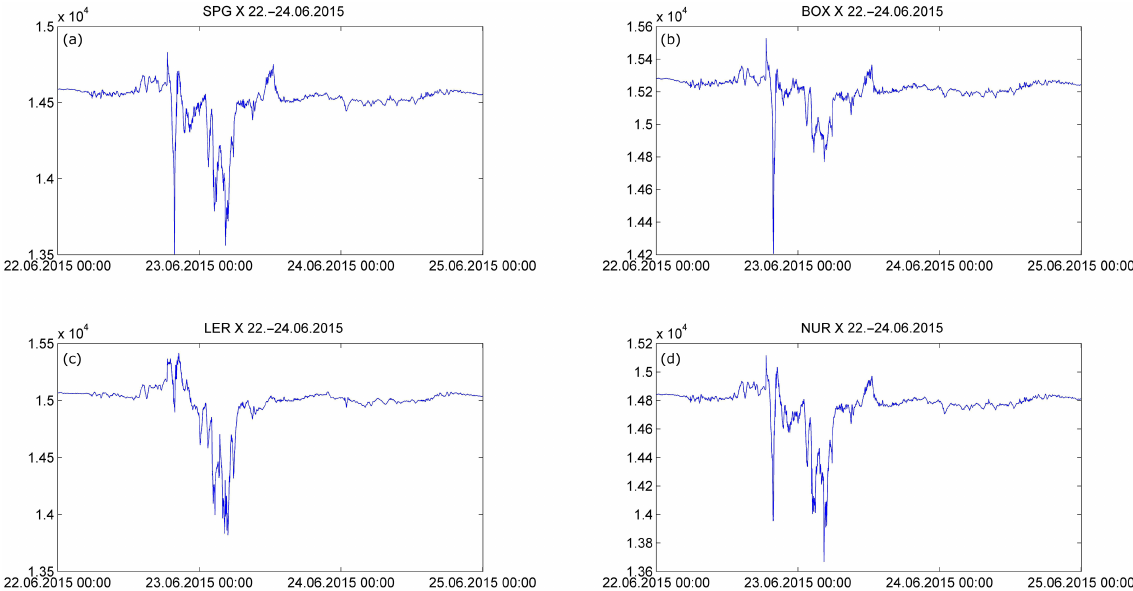
Figure 6. Minute magnetic variations of the X component during the magnetic storm of 22–24 June 2015.